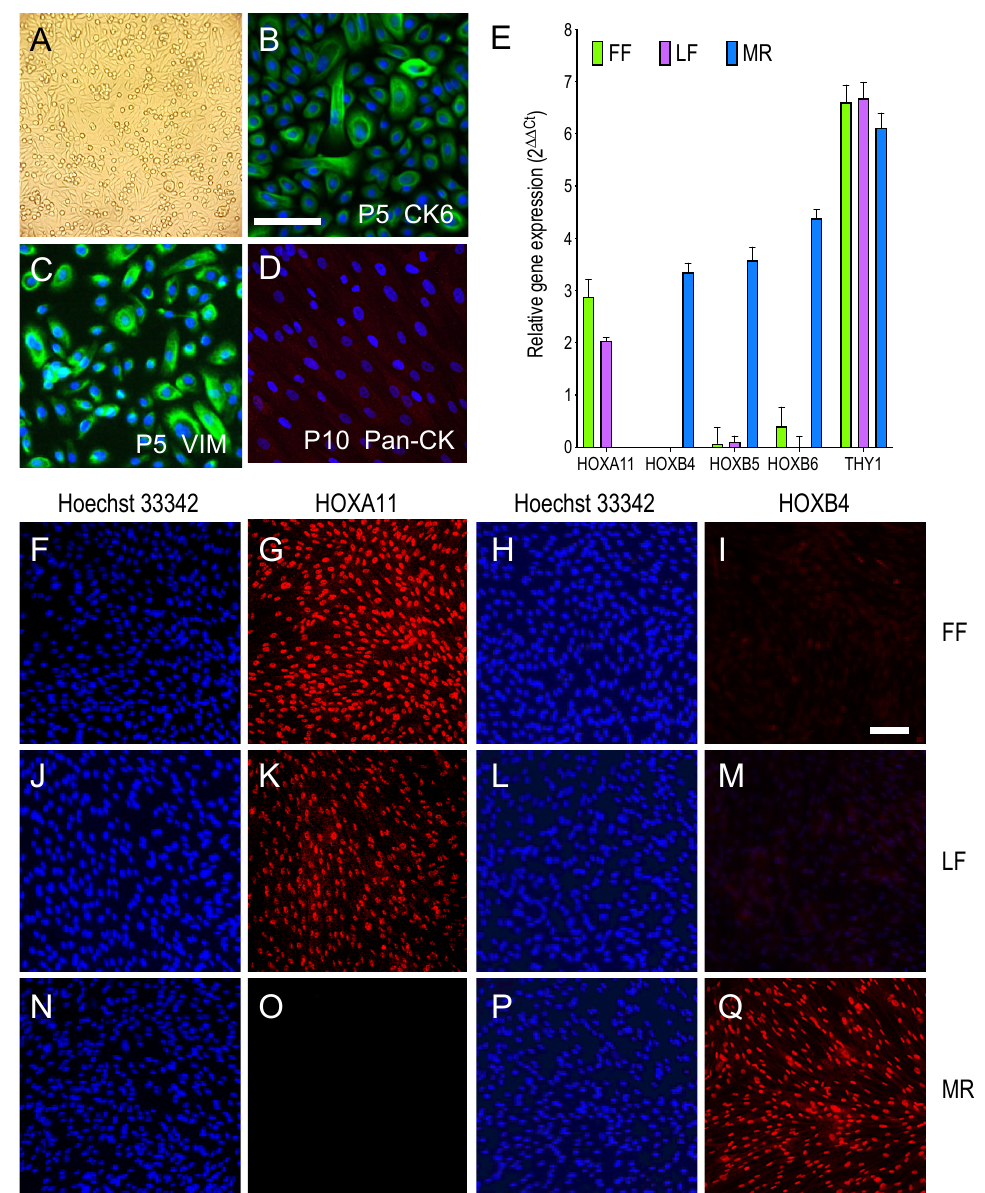
Figure 1. Cell morphology and expression of marker proteins in LF, FF, and MR cultures. ( A ) Representative light micrograph of passage zero oral mucosal cells at confluency (200× magnification). ( B – D ) Representative micrographs of passage five (P5) oral mucosal cells stained for cytokeratin 6 (CK6, green signal) or for vimentin (VIM, green signal), and of passage ten (P10) cells stained with anti-pan-cytokeratin (Pan-CK, red) antibodies. Hoechst 33,342 was used to highlight nuclei (blue). Identical signal patterns were observed in three replicate assays. ( E ) Relative expression (2 ΔΔ Ct ) of the homeobox A11, B4, B5, and B6, and THY1 genes in LF, FF, and MR cells as determined by reverse-transcription real-time quantitative PCR analysis. Mean and standard deviation values from replicate PCR wells in a single experiment are shown. ( F – Q ) Representative micrographs of LF (passage 18), FF (passage 25) and MR (passage 22) cells stained for HOXA11 or HOXB4 (red) and with Hoechst 33,342 (blue). Identical signal patterns were observed in two replicate assays. Bars = 100 µ